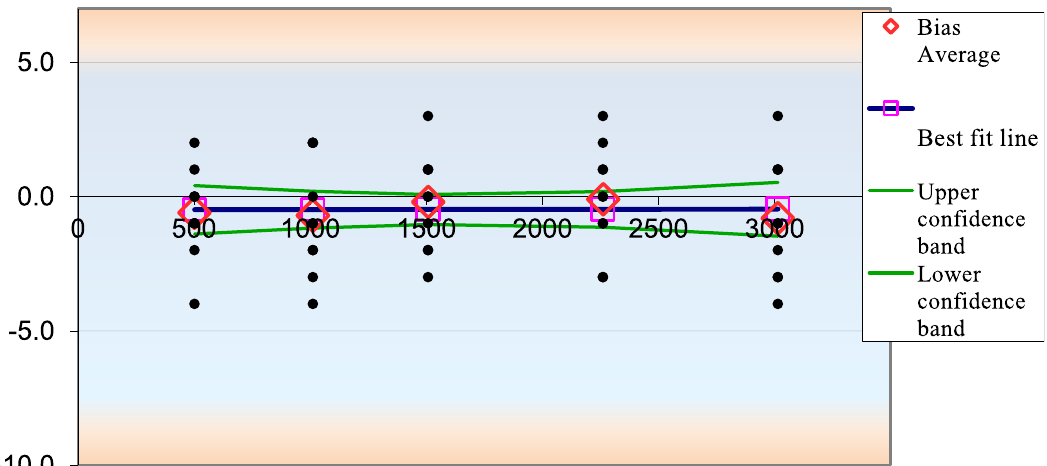
Fig. 4. Example 4, FAC-1, measurement system A: Linearity accepted by statzero conditions. Reference values are on the x-axis in nm